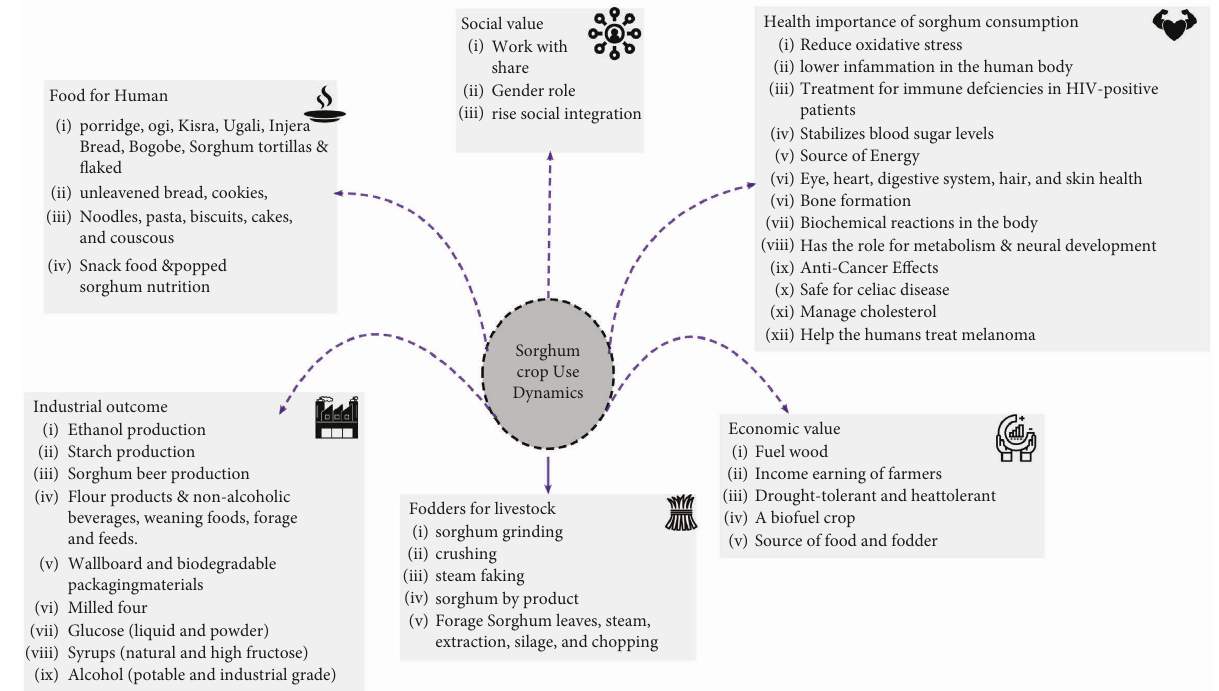
Figure 5: Use dynamics of sorghum multipurpose crop. Source: Authors’